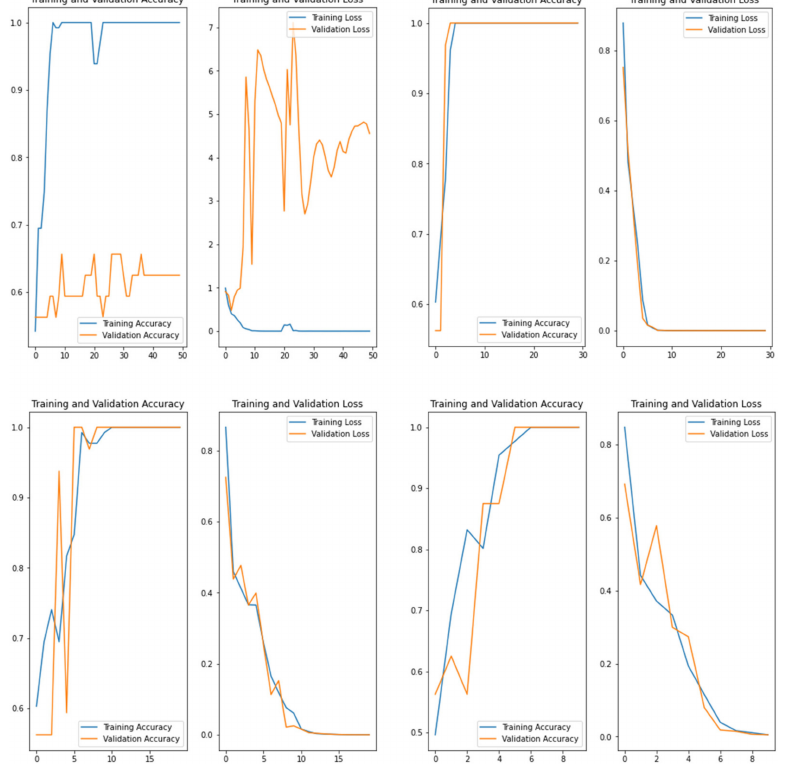
Figure 7. Illustration of model accuracy rate for 50, 30, 20, and 10 epochs for DB4 dataset generated as synthetic